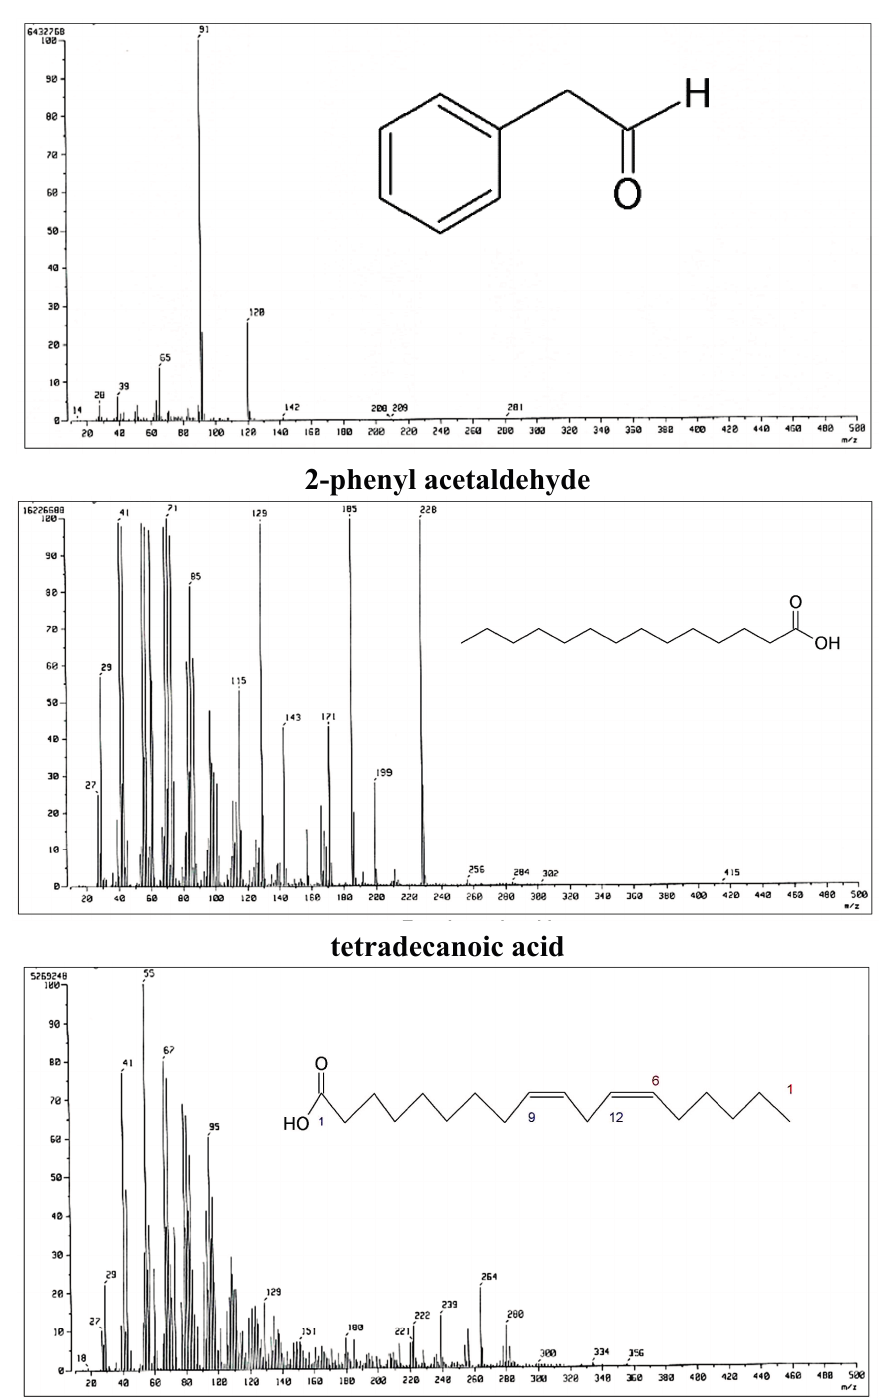
Figure 3. Profiles of mass spectra and chemical structures of important compounds present in Laminaria japonica L. essential oil